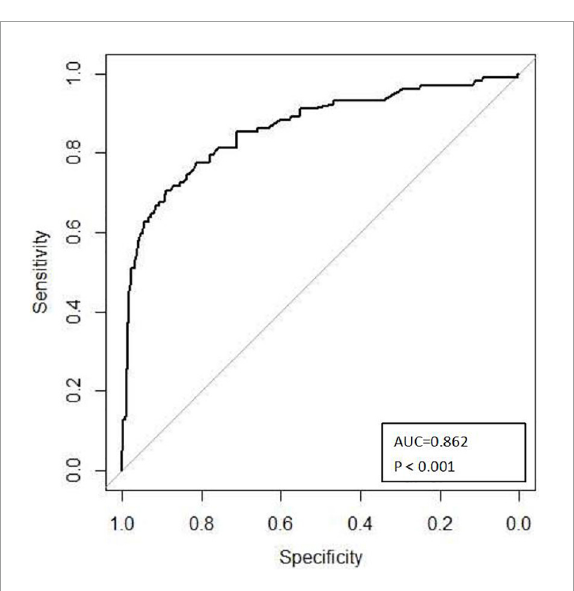
FIGURE3 ROC curves to predict the failure rate of the Pavlik